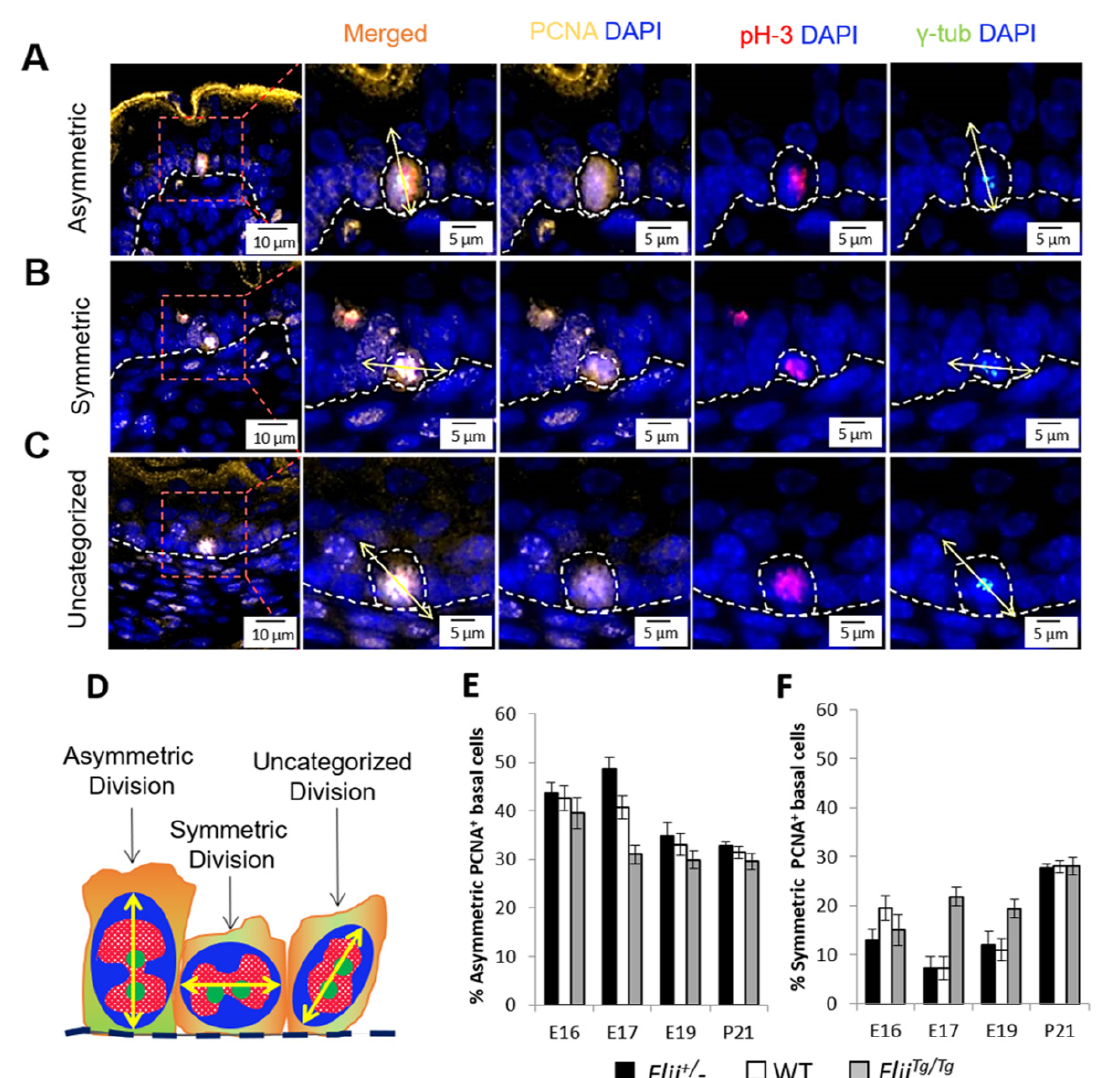
Figure 3. Altered expression of the Flii gene results in proliferating basal cells adopting different cell division patterns during late embryonic development. ( A ) Representative image of proliferating basal cell going through asymmetric division with division plane perpendicular to the basement membrane, ( B ) symmetric division with division plane parallel to the basement membrane and ( C ) uncategorized division with division plane diagonal to the basement membrane. Triple immunofluorescent staining of PCNA (pseudo-stained yellow) identifying proliferating cell, pH3 (pseudo-stained red) identifying mitotic chromosomes during metaphase of proliferation and γ -tub (pseudo-stained green) identifying centrosomal axis. Nuclear DAPI staining is shown as pseudo-stained blue. The epidermal-dermal junction is shown by white dash lines. Scale bars, 5 µ m. ( D ) Cartoon summarizing the three division categories. ( E ) Quantification of proliferating basal cells going through the asymmetric division with perpendicular division plane and ( F ) symmetric division with parallel division plane and as % of total proliferating events with an average of 100 proliferating events per group at E16, E17, E19 and P21 in Flii +/ − , Flii knockdown; WT, wild-type; FIii Tg/Tg , Flii overexpressing mouse skin. N = 6. Mean ± SEM.